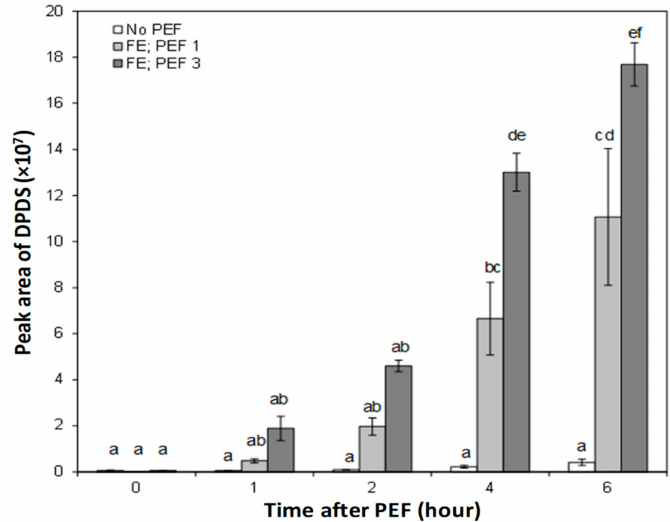
Figure 7. Extracted ion peak area of dipropyl disulfide (DPDS) ( m / z 150) detected in the headspace of the sodium phosphate bu ff er over the course of 6 h of steeping with untreated and PEF-treated onion bulbs. Bars represent mean ± standard error ( n = 3). Significant di ff erences ( p < 0.05) between the means are indicated with di ff erent